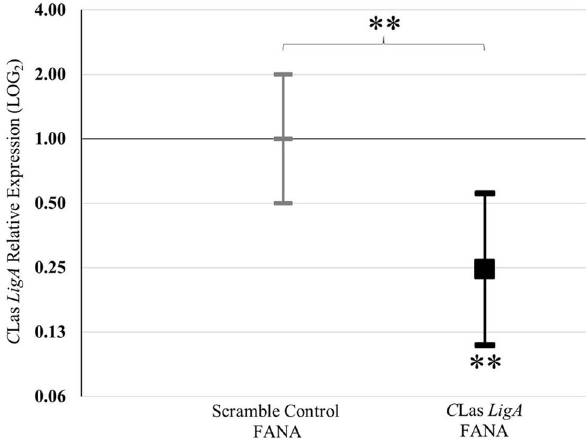
Figure 6. Distribution of C Las titer in D. citri adults after feeding 5 µM FANA solutions for seven days. Statistical differences between the treatments ( P ≤ 0.05) are designated by different letters (KW-H [2, 27] = 10.6984, p = 0.0048). Results are medians of triplicate experiments.